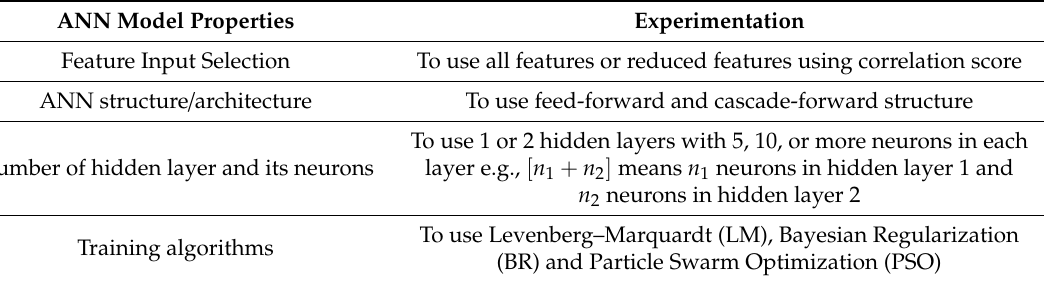
Table 2. Artificial neural network (ANN)-based model